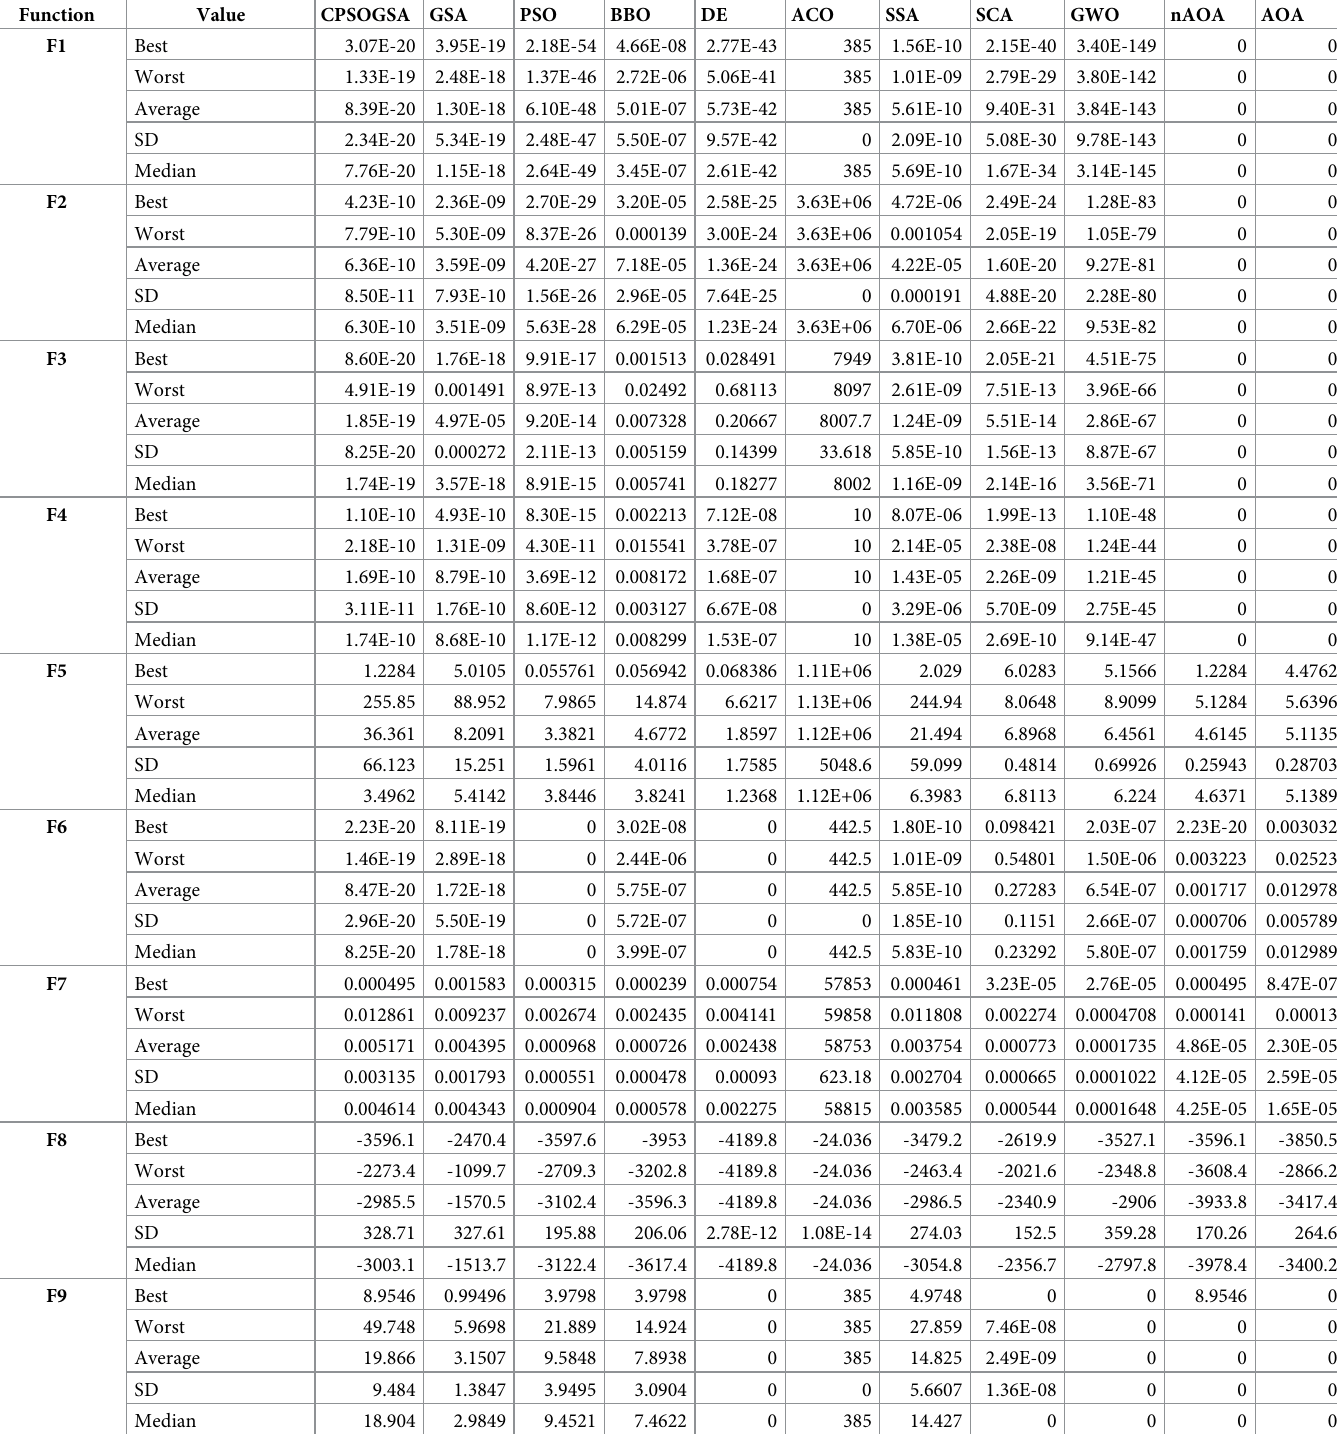
Table 4. Classical benchmark